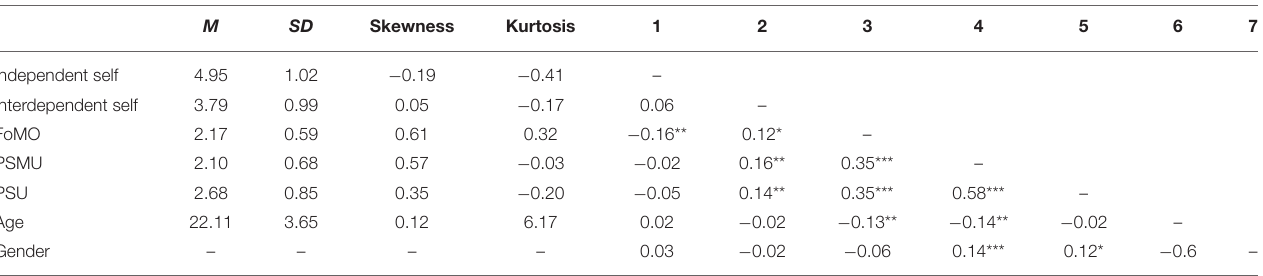
TABLE 1 | Descriptive statistics and correlation coefficients between study variables.